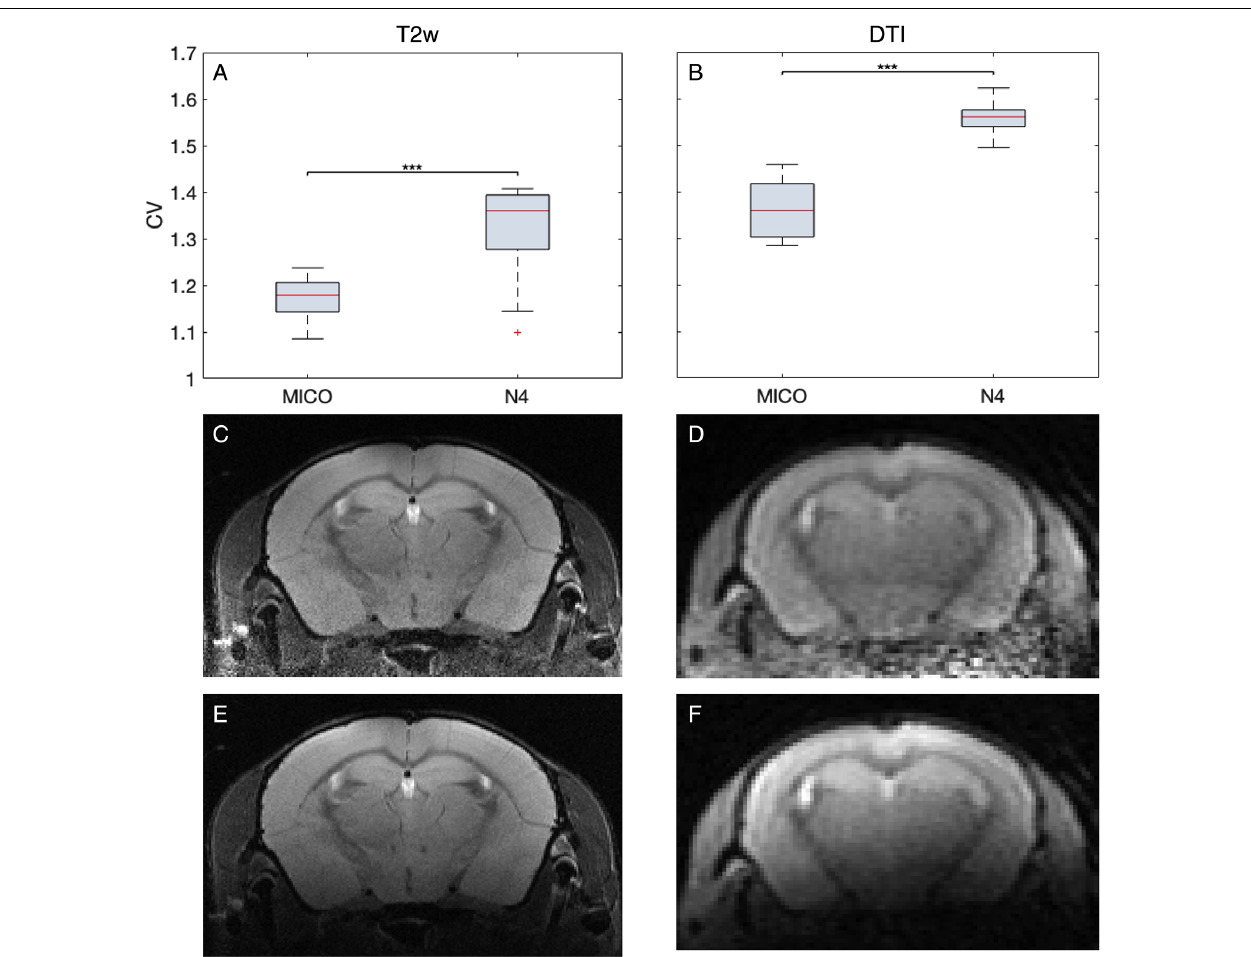
FIGURE 5 | Quantitative and qualitative comparison of MICO and N4 bias-field correction. The calculation of the degree of homogeneity revealed lower coefficient of variations (CV) for MICO compared to N4 for 22 T2w and 10 DTI measurements (A,B) . Representative MR images comparing MICO (C,D) and N4 (E,F) bias-field corrected images for T2w and DTI, respectively.